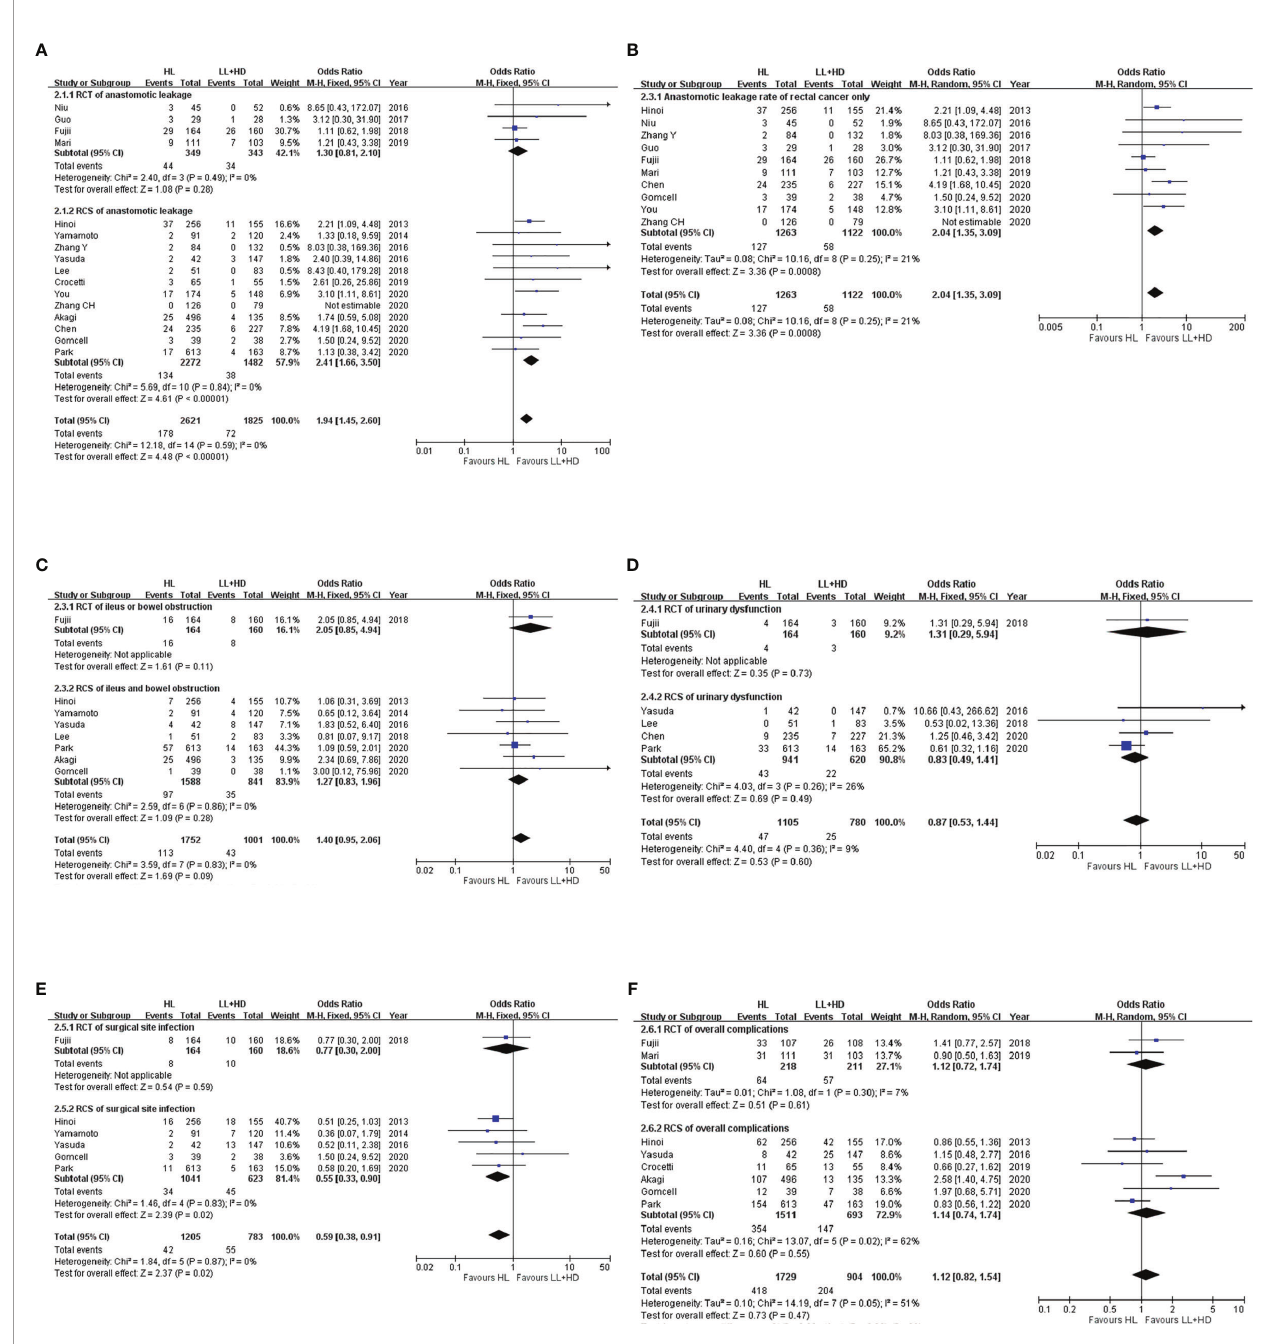
FIGURE 2 | Meta-analysis of postoperative morbidity. (A) Forest plot of the anastomotic leakage following HL versus LL+HD. (B) Forest plot of anastomotic leakage in rectal cancer following HL versus LL+HD. (C) Forest plot of postoperative ileus following HL versus LL+HD. (D) Forest plot of urinary dysfunction following HL versus LL+HD. (E) Forest plot of the surgical site infection following HL versus LL+HD. (F) Forest plot of the total complications following HL versus LL+HD. HL, high ligation of the inferior mesenteric artery; LL+HD, low ligation of the inferior mesenteric artery plus high dissection of lymph